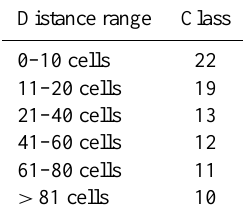
Table 2. Relative slope position classes.